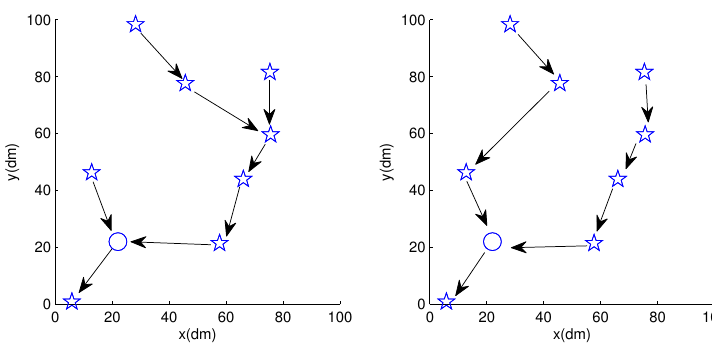
Figure 9. Structure of the experimental network using SCFSen .